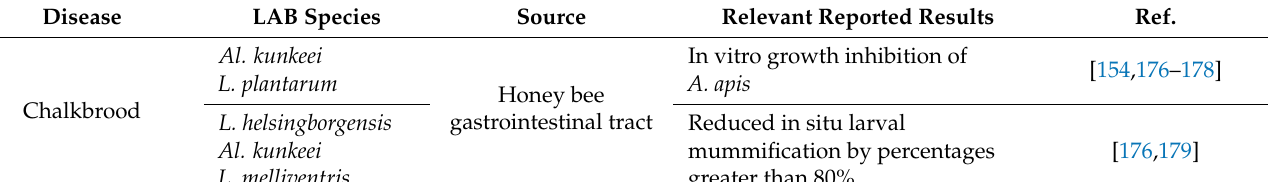
Table 2. Overview of the main results obtained using LABs for the control of the honey bee diseases. Disease LAB Species Source Relevant Reported Results